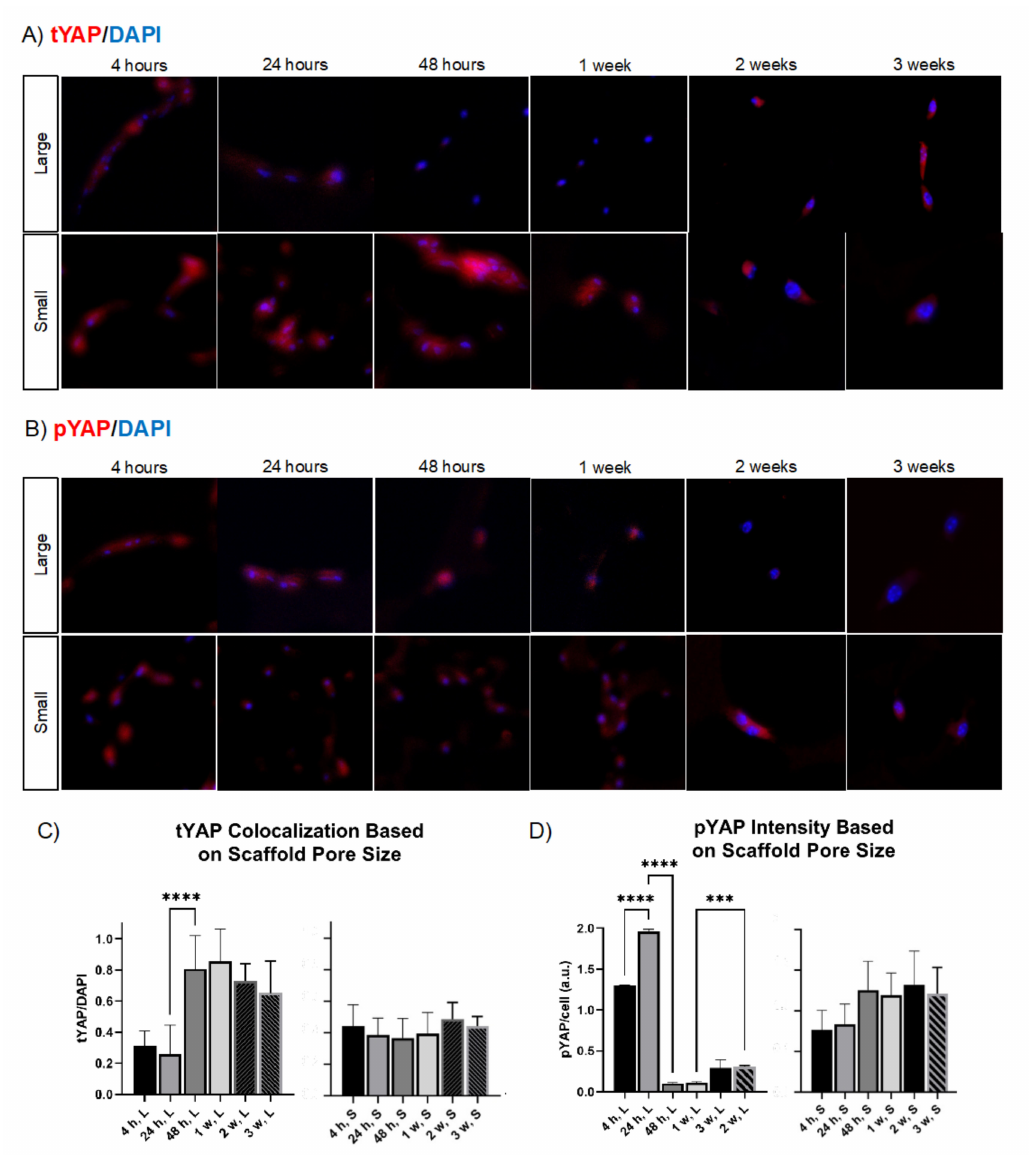
Figure 10. Cell–scaffold constructs are cultured for up to 3 weeks in vitro and expression of total YAP (tYAP, ( A )) and YAP phosphorylation (pYAP, ( B )) are observed in histologic sections by immunoflu- orescence and confocal laser microscopy. YAP nuclear localization ( C ) and YAP phosphorylation intensity per cell ( D ) are quantified by image analysis. *** = p < 0.001, **** = p <